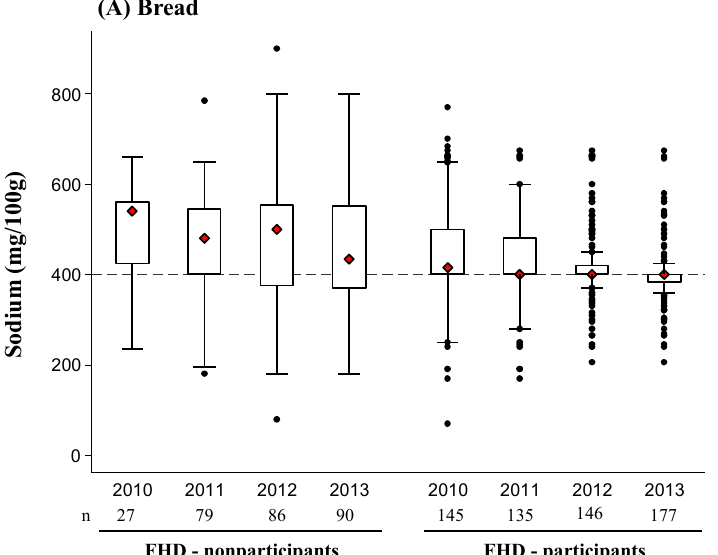
Figure 3. Distribution of sodium values from 2010 to 2013 for ( A ) bread, ( B ) ham/bacon/cured meats and ( C ) ready-to-eat (RTE) breakfast cereals. The box displays the interquartile range, and the median value is marked as a diamond. The lines